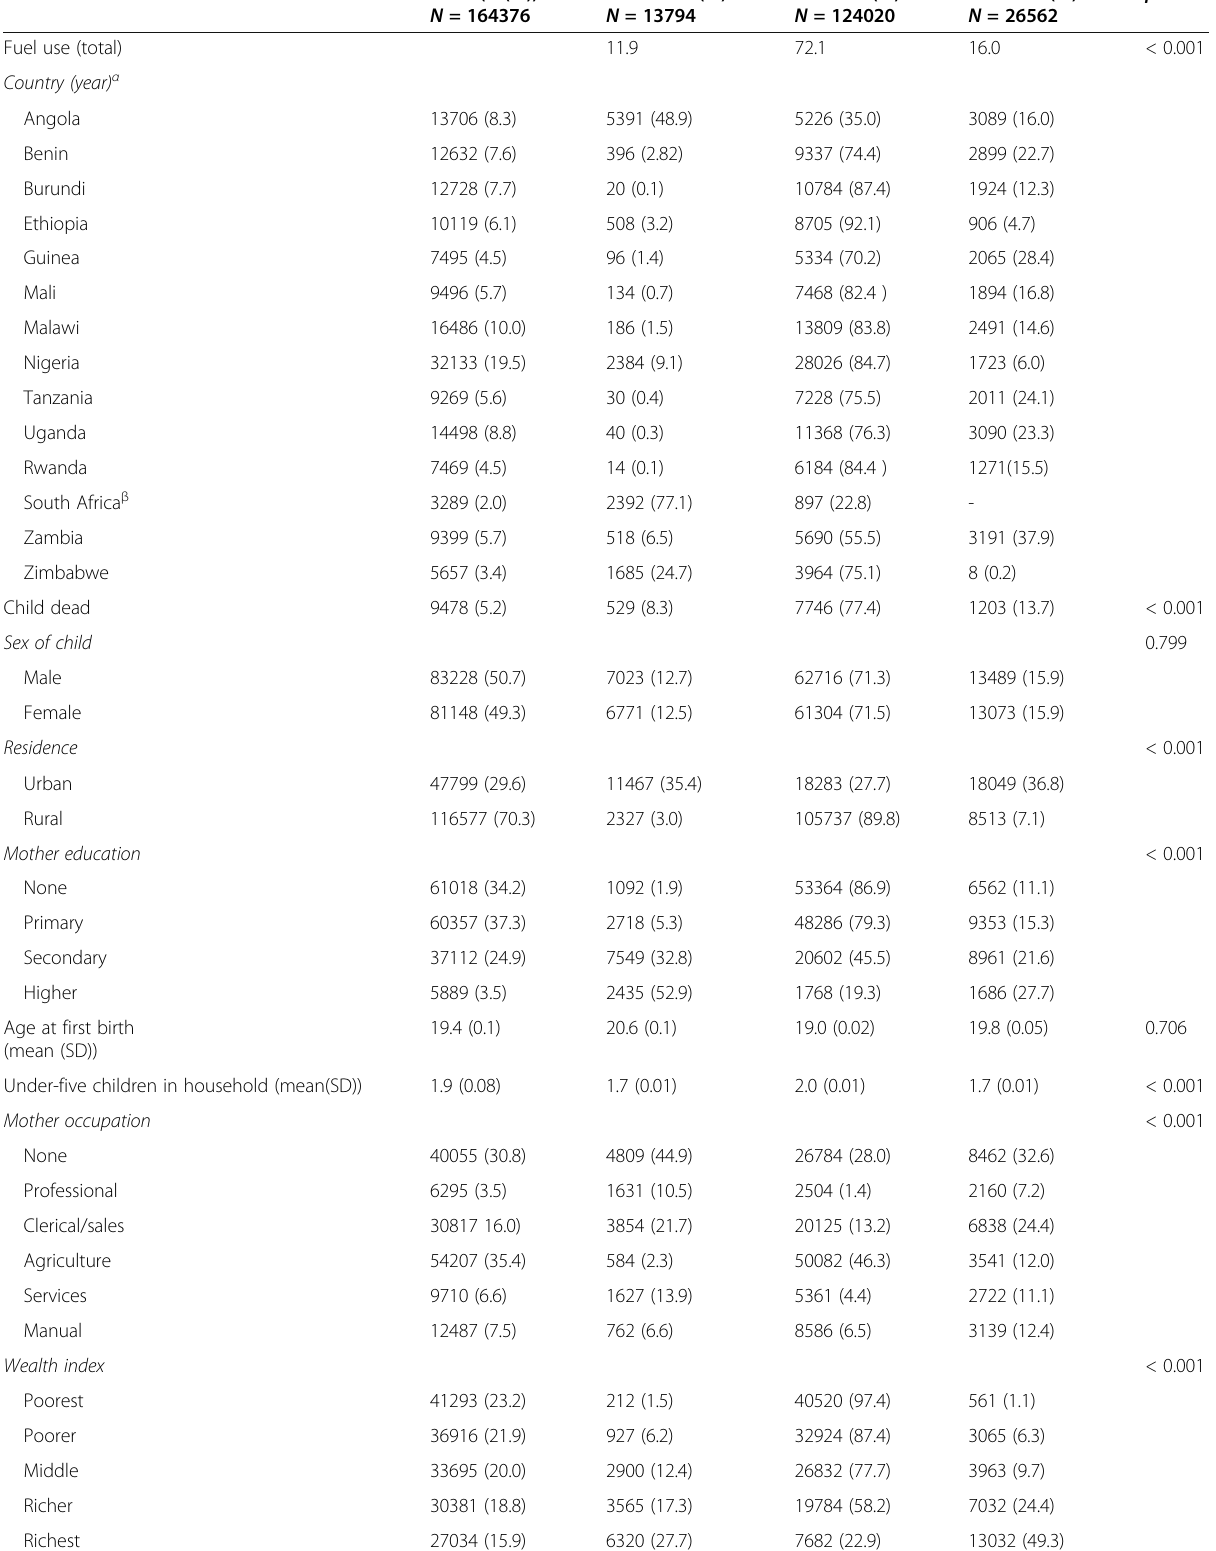
Table 1 Study population characteristics by cooking fuel type ( N =